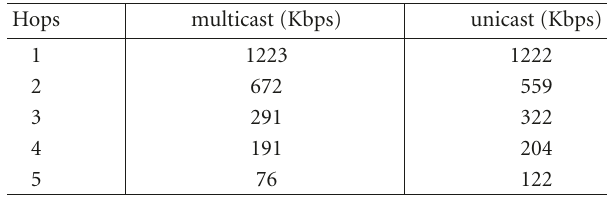
Table 1: Throughput: routing and autoconfiguration.